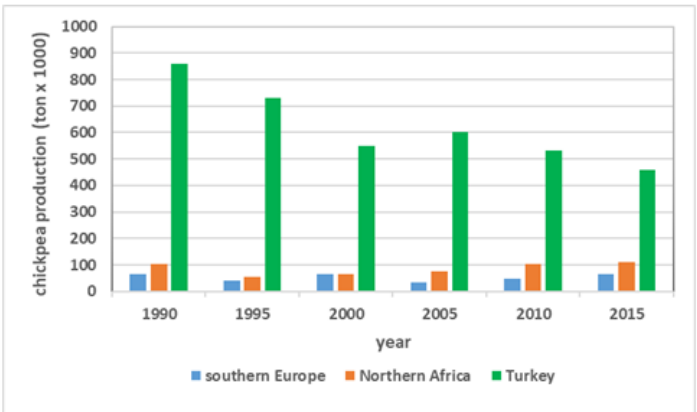
Figure 1. Chickpea production from 1990 to 2015 (FAOSTAT). Northern African countries: Algeria, Egypt, Libya, Morocco, Tunisia. Southern European countries: Croatia, France, Greece, Italy, North Macedonia, Portugal, Spain.